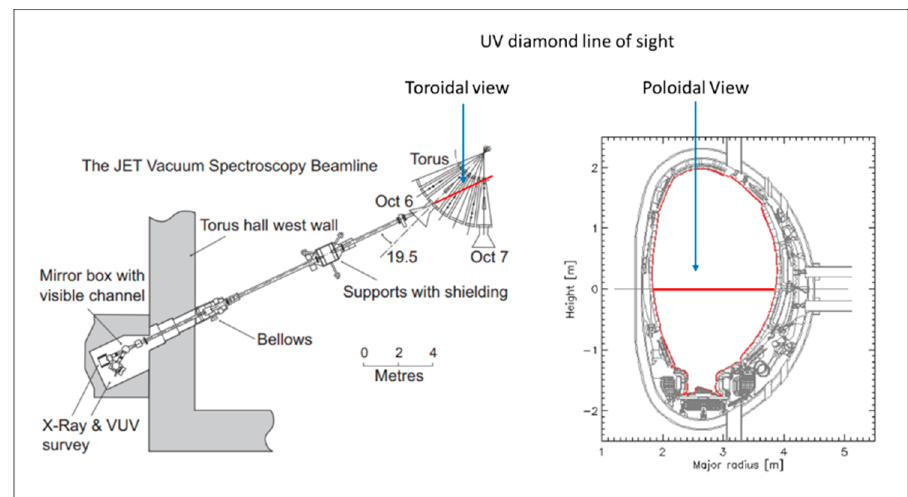
Figure 3. UV diamond line of sight.